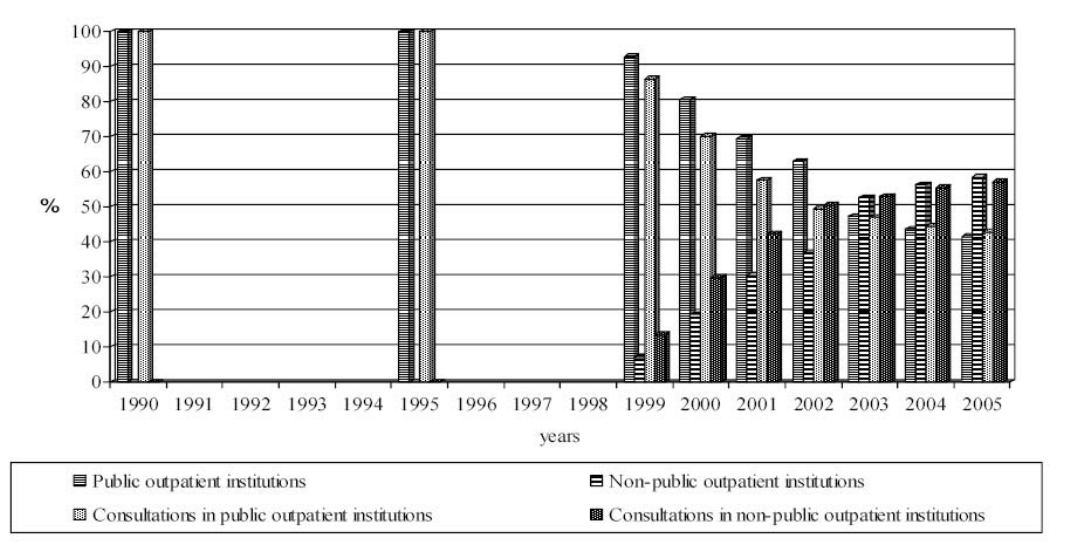
Fig. 2 Effects of the ownership transformation of outpatient institutions in rural areas.